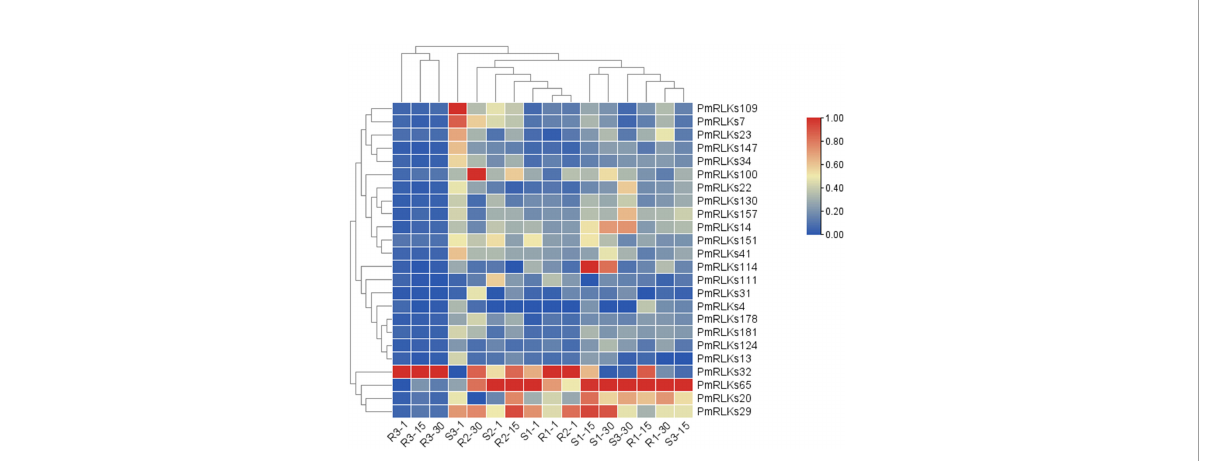
FIGURE 2 Heat map of PmRLK proteins. The PmRLK family members in Pinus massoniana that had high homology with the proteins of Arabidopsis thaliana are shown, and the heat map includes data for samples collected at 1, 15, and 30 days after inoculation. The expression level of the sample is relative to that of the control. The color scale represents the relative fold change in expression